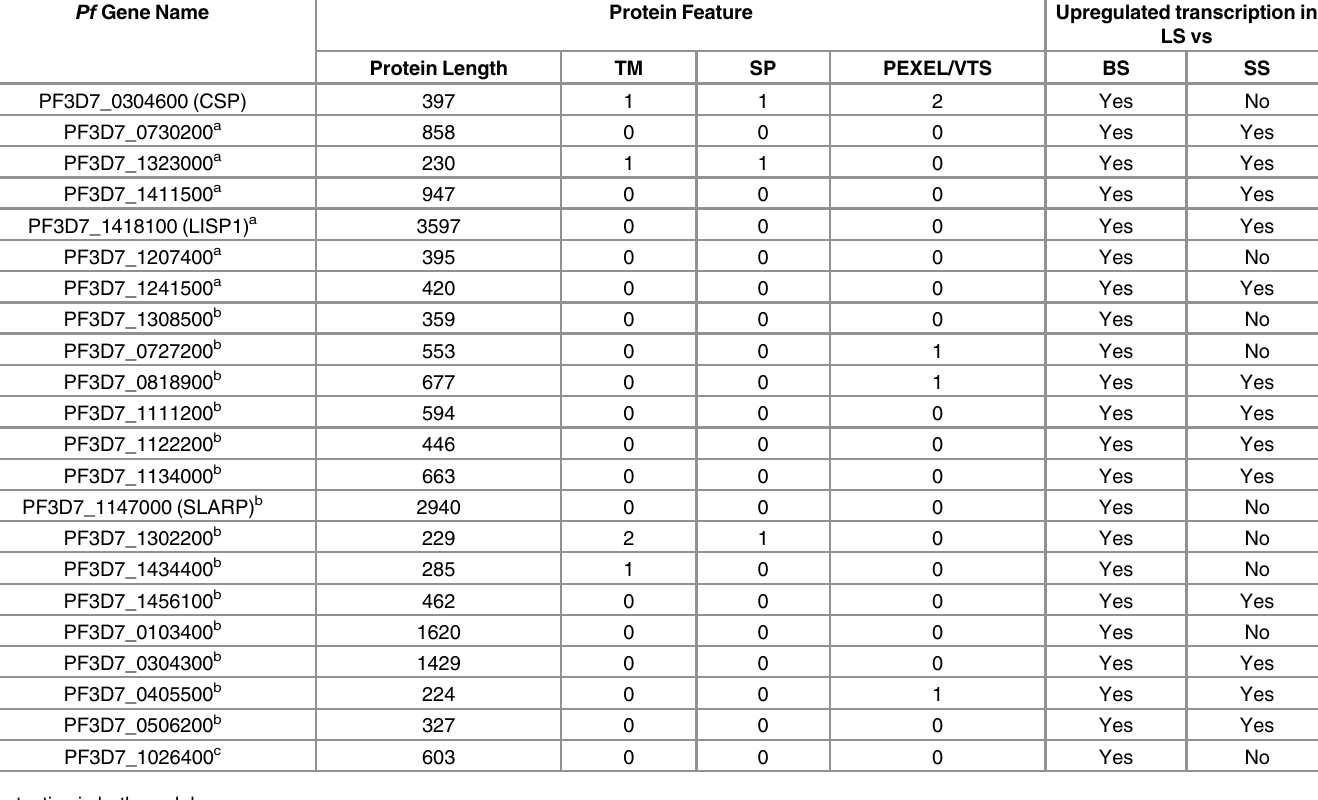
Table 2. Protein features and transcriptional profiles of selected candidate